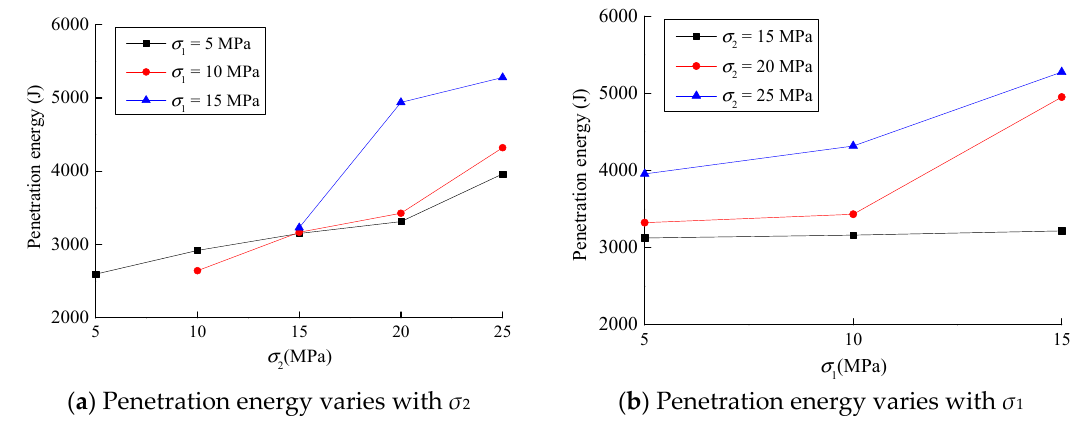
Figure 10. Penetration energy under different confining pressure levels.